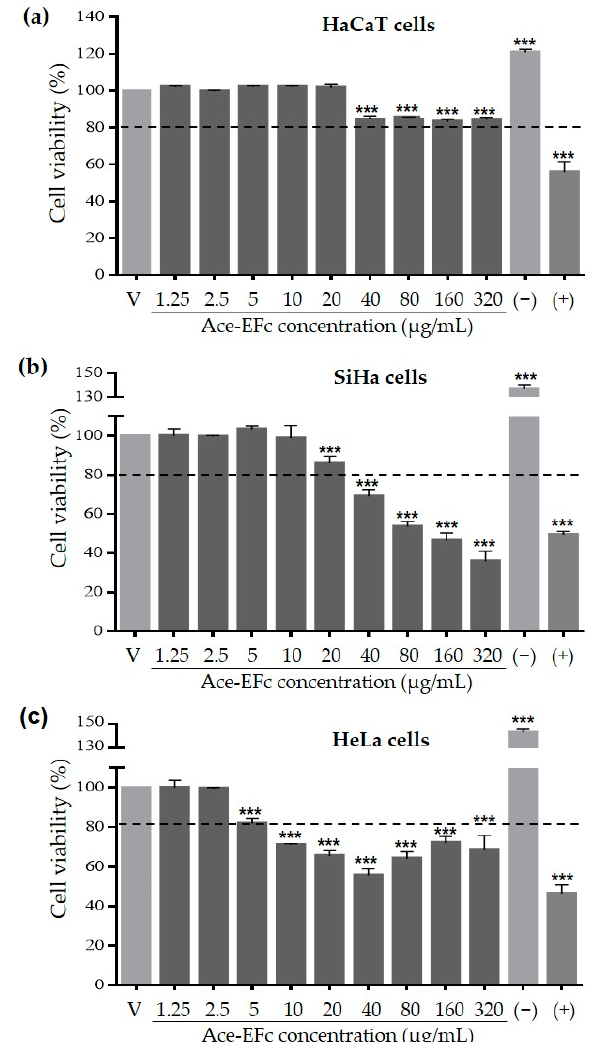
Figure 1 Figure 1. Effect of acetone extract from F. crocata (Ace-EFc) on cell viability. HaCaT, SiHa, and HeLa cells were treated with 0–320 µ g/mL of Ace-EFc for 24 h. MTT assay for ( a ) HaCaT, ( b ) SiHa, and ( c ) HeLa cells. V: vehicle, cells treated with diluent of the extracts (DMSO < 1%); ( − ): negative control, 10% FBS. (+): Positive control, 100 µ M Ara-C (cytarabine). Results were expressed as the mean ± SD of three independent experiments. One-way ANOVA, Dunnett’s test: *** p < 0.001 versus